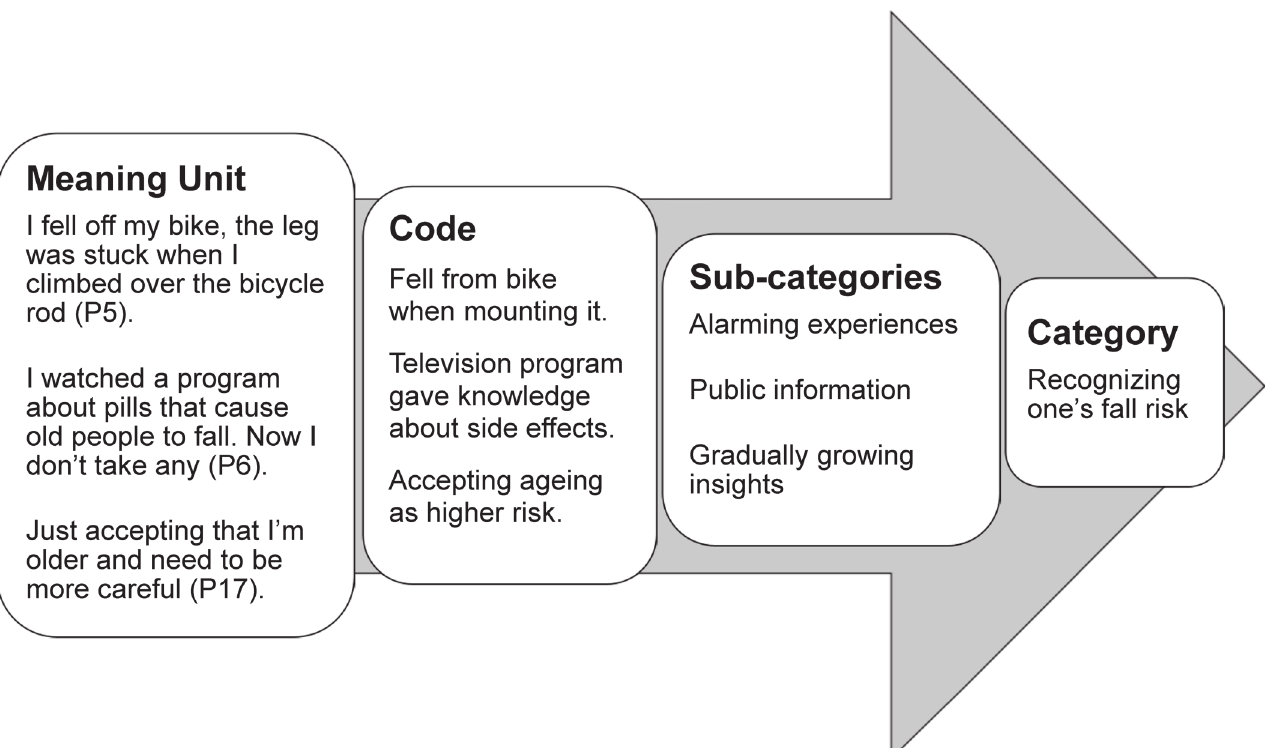
Fig 1. Transforming meaning unit into category. Examples of the transformation process from meaning unit to category using qualitative content